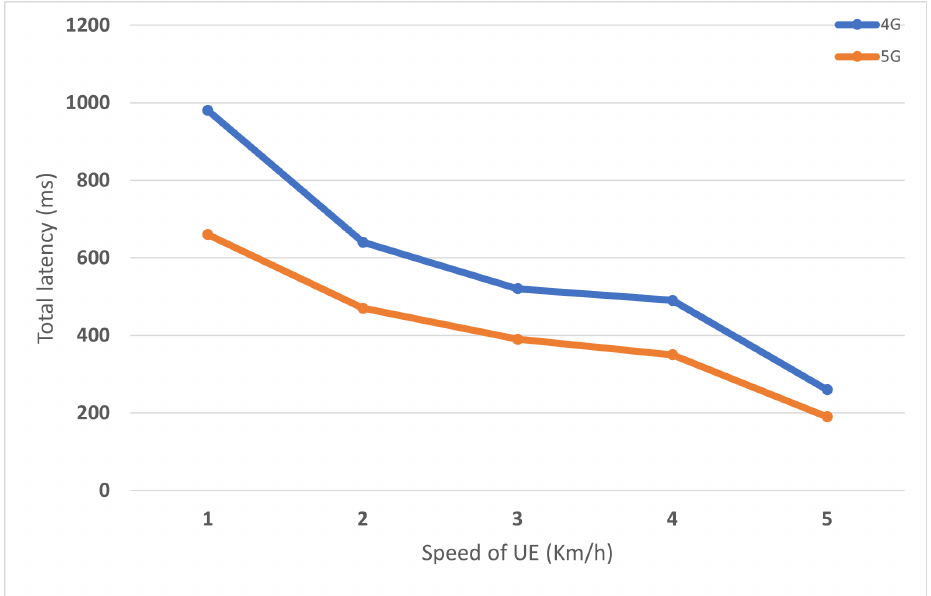
Figure 17. Comparison of 4G and proposed 5G in terms of latency of Inter-Handover with varied UE